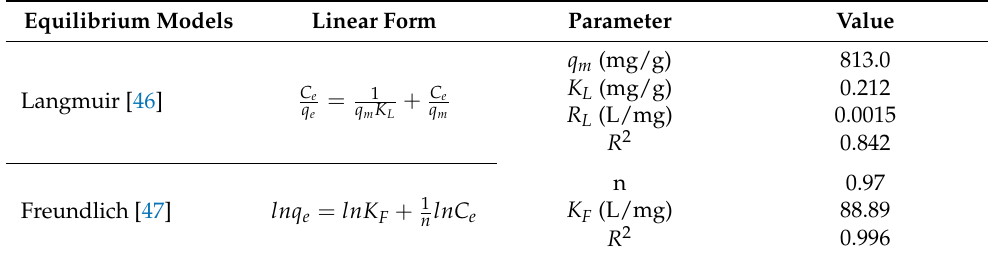
Table 1. Used equilibrium isotherm models for the adsorption of BF onto CaO-g-C 3 N 4 nanosorbent. Equilibrium Models